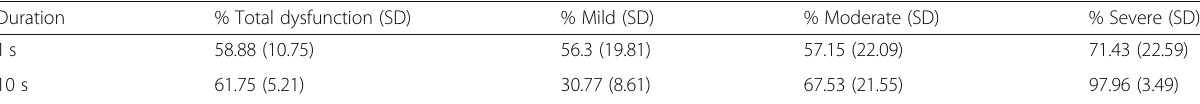
Table 9 Experiment 3: Mean percentage accuracy for the ventricular function categorization task when detection was correct ( n = 14) Duration